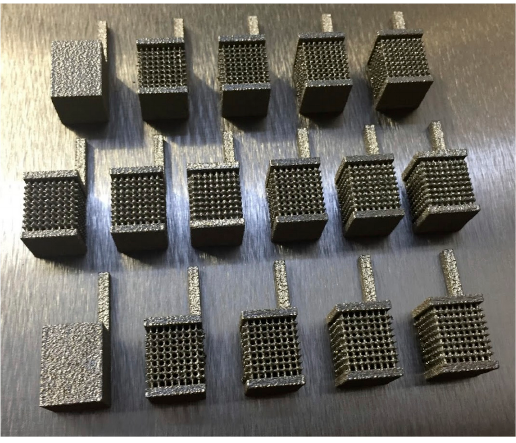
Figure 2 . Fabricated samples for electrochemical tests.